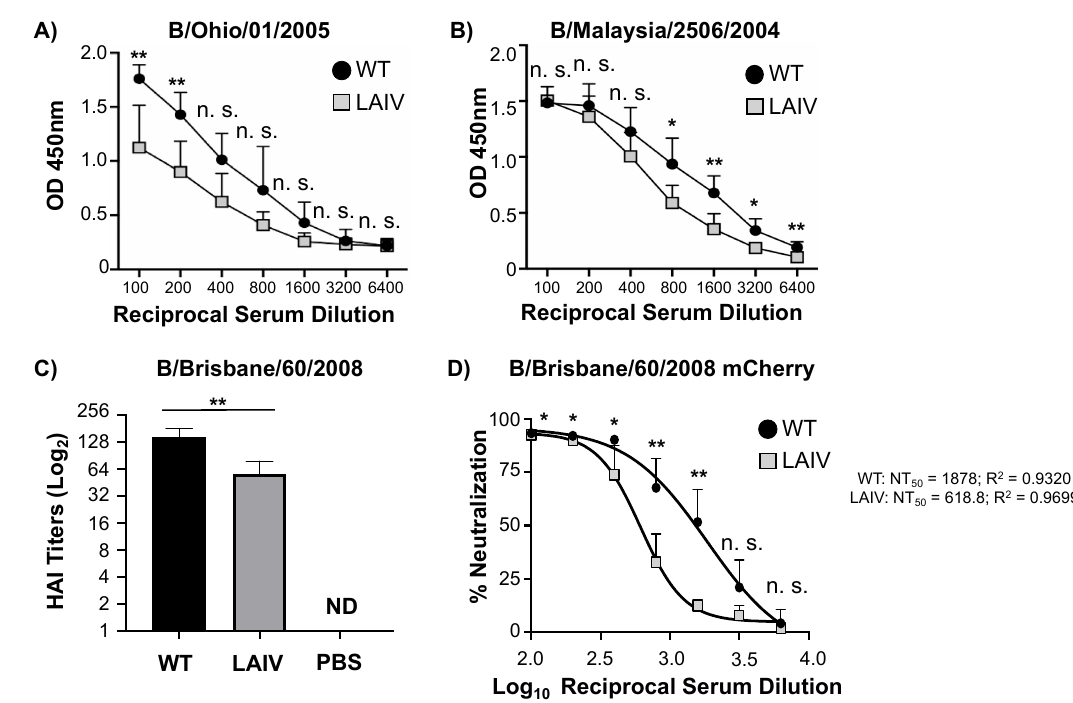
Figure 5. B/Brisbane/60/2008 MDV LAIV immunogenicity: C57BL/6J 6-weeks-old female mice ( n = 6) were intranasally infected with 10 6 FFU of B/Brisbane/60/2008 WT (black) or MDV LAIV (grey). Serum was collected at 14 days post-infection and RDE treated/heat inactivated. ( A , B ) ELISA: Total IgG Ab responses were determined by ELISA with purified HA protein from either B/Ohio/1/2005 ( A ) or B/Malaysia/2506/2004 ( B ) Victoria lineage IBV. OD, Optical Density. ( C , D ) HAI and microneutralization assays: Neutralizing antibodies against B/Brisbane/60/2008 were determined by HAI ( C ) and fluorescent-based microneutralization ( D ) assays. Data is represented as the mean and SD. Student t test was performed to determine p values. *, p < 0.05; **, p < 0.01; n.s.: not significant. ND = Not detected.